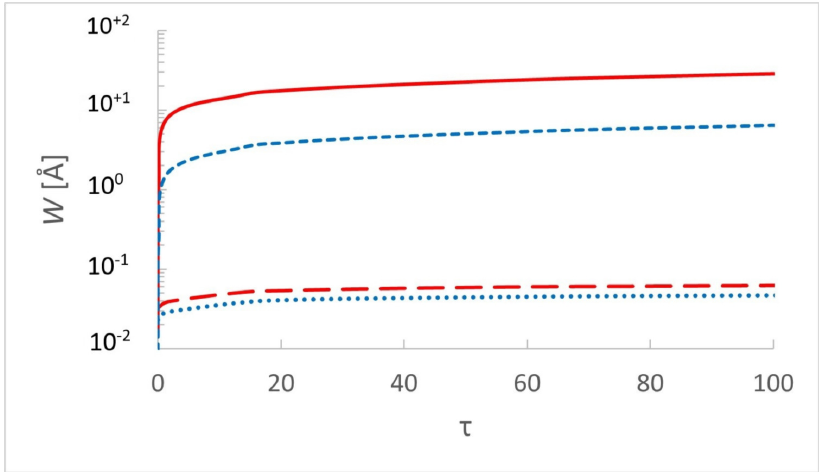
Figure 2. Same as in Figure 1 but for the atmosphere of a DB white dwarf. The atmosphere model from [38] with parameters T ef f = 25,000 K and log g =